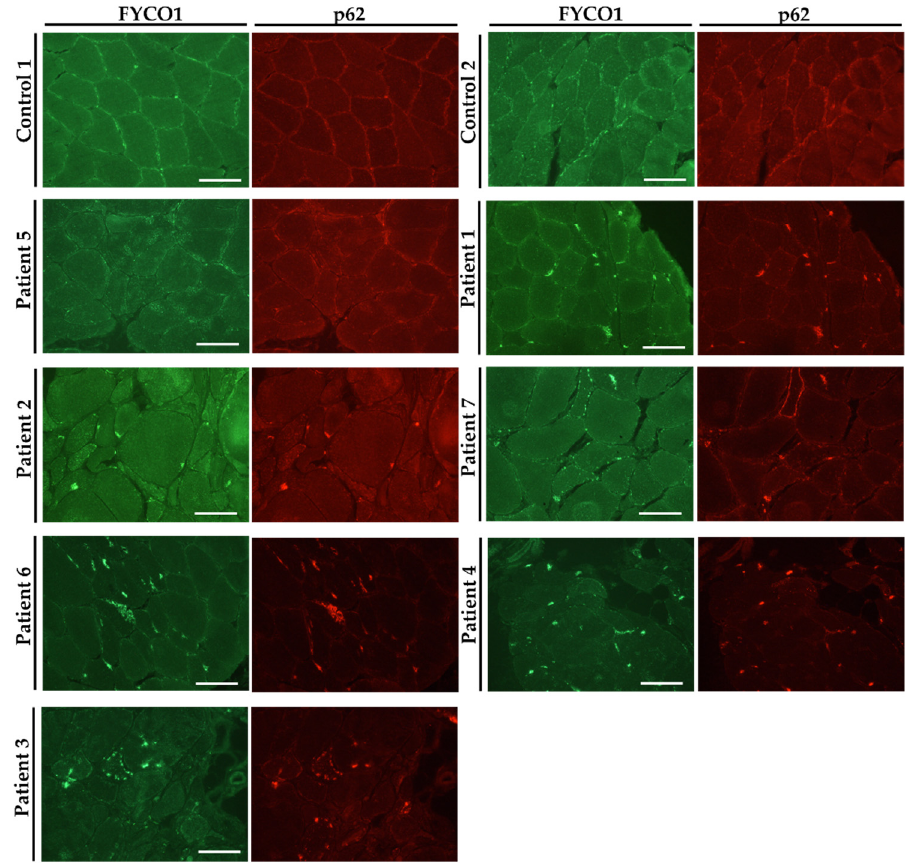
Figure 1 . Immunofluorescence studies on skeletal muscle biopsies derived from VCP –patients and controls. Increase of FYCO1–immunoreactivity (green) within the sarcoplasm and at the sub- sarcolemmal region which partially overlaps with p62 (red). Images are serialized in succession according to the presence of FYCO1–p62 immunoreactivity. Two representative controls are shown. Scale bars: 100 µ